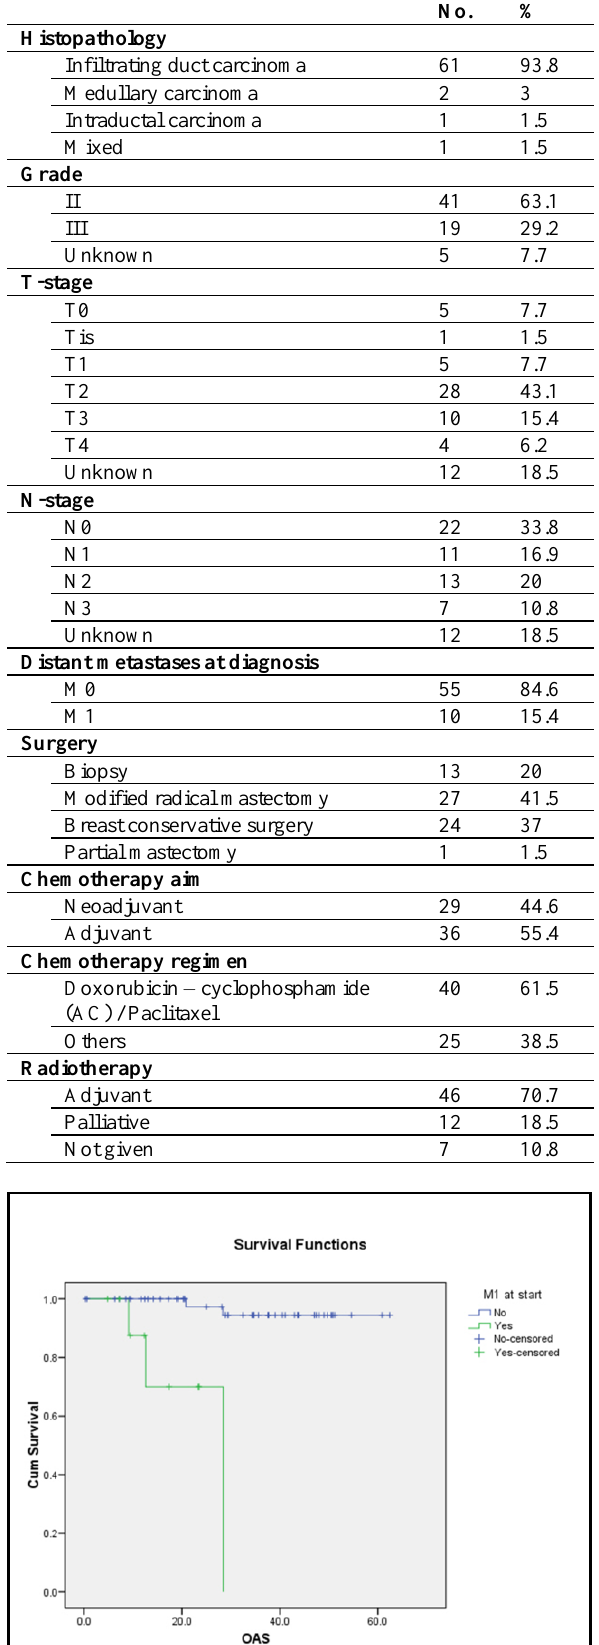
Table 2: Tumor characteristics and treatment (n= 65 patients)